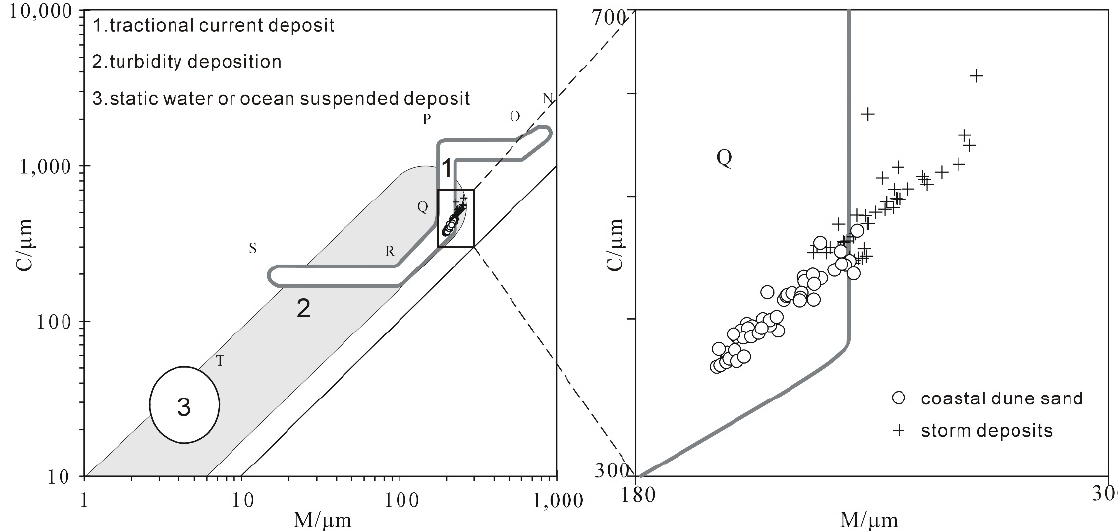
Figure 4. C-M schema of different facies in the Wutou section.